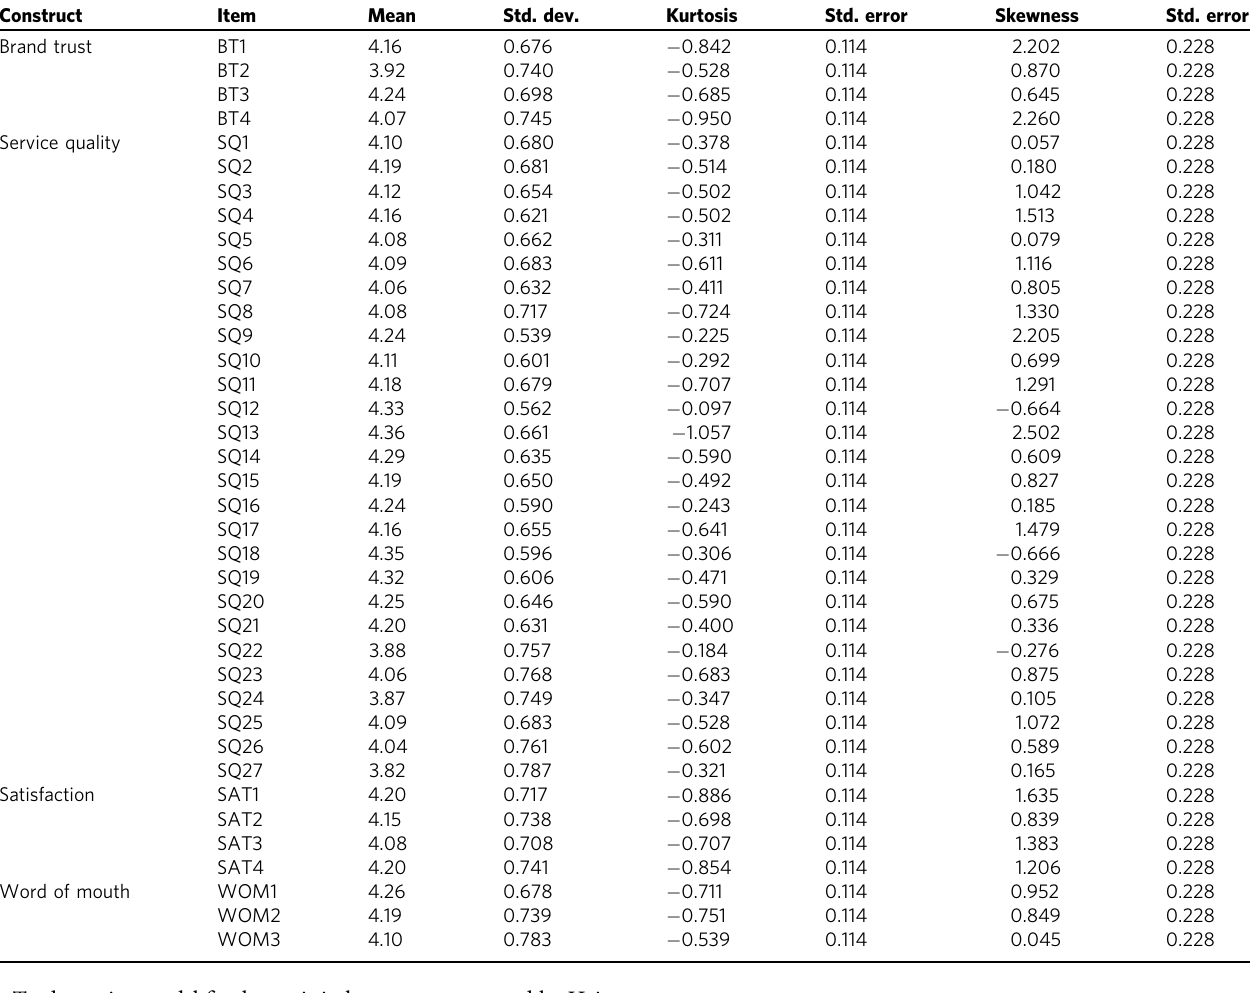
Table 2 Mean, standard deviation and assessment of normality. Construct Item Mean Std. dev. Brand trust BT1